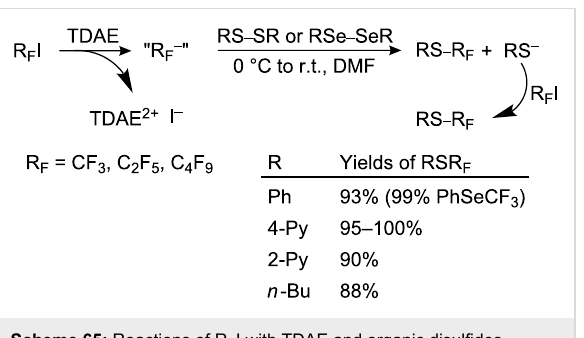
Yield of ArSR F %